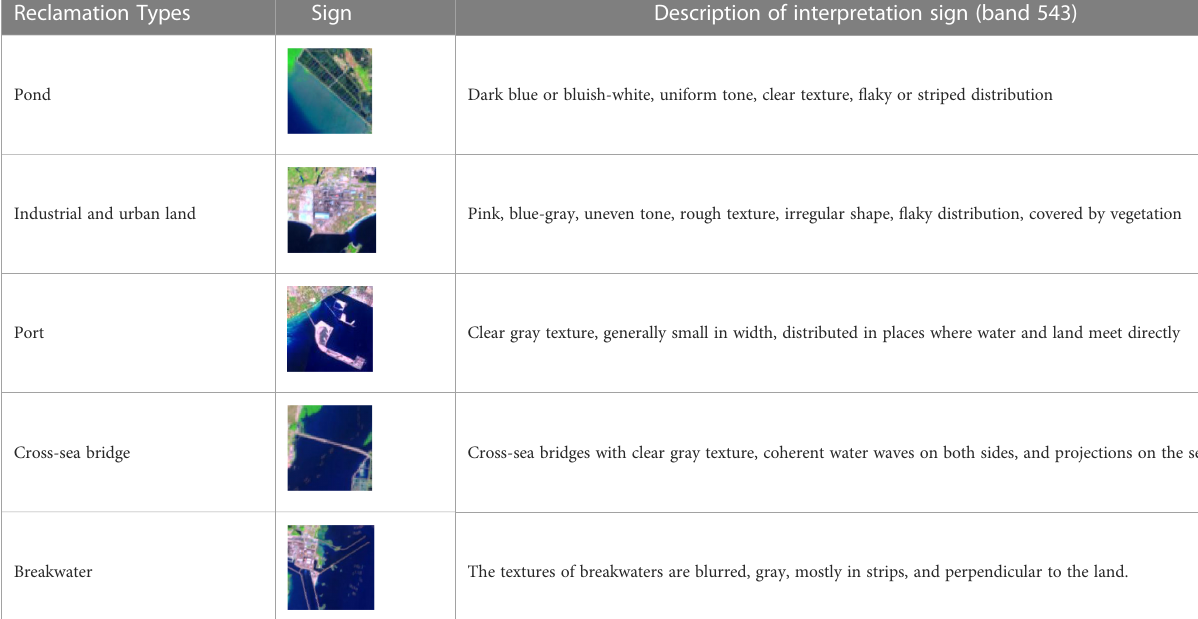
TABLE 2 Interpretation signs for different types of reclamation and utilization.